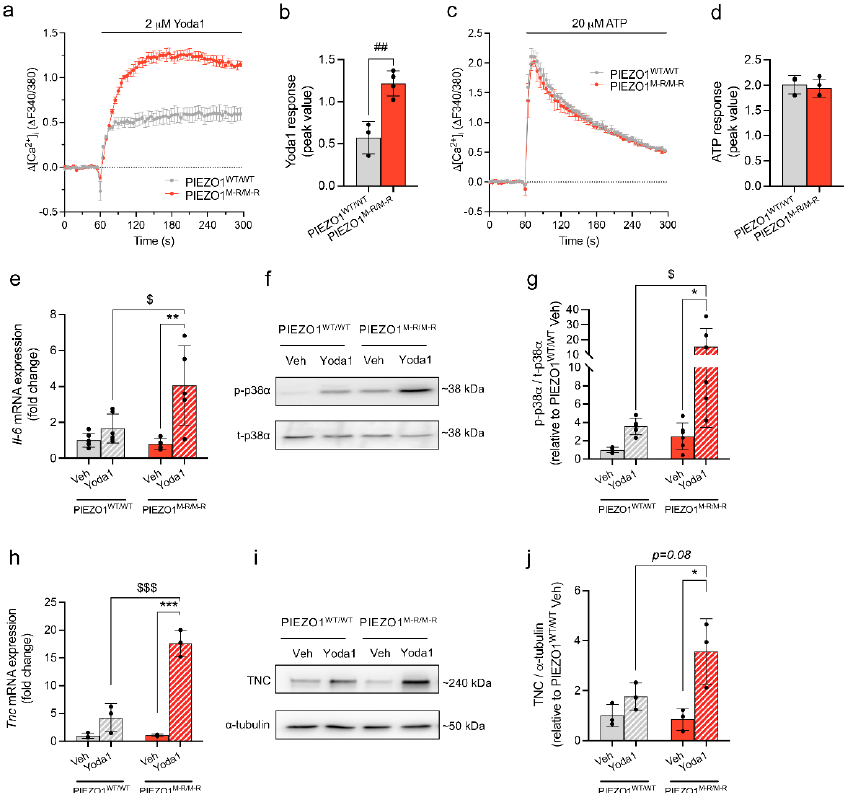
Figure 4. PIEZO1 gain-of-function mutation causes increased agonist-evoked Ca 2+ -entry in cardiac fibroblasts and amplified downstream signalling. ( a ) Examples of changes ( ∆ ) in intracellular free Ca 2+ above baseline in response to 2 µ M Yoda1 in cultured fibroblasts isolated from PIEZO1 WT/WT or PIEZO1 M-R/M-R mice ( n = 3 replicates per data point). ( b ) Mean data for the type of experiment shown in ( a ), measured 60–90 s after Yoda1 treatment. ( c ) As for ( a ), but 20 µ M ATP was used in place of Yoda1. ( d ) Mean data for the type of experiment shown in ( c ), measured 60–90 s after ATP treatment. ( e ) Quantitative PCR mRNA expression data for Il-6 gene in PIEZO1 WT/WT and PIEZO1 M-R/M-R fibroblasts exposed to 10 µ M Yoda1 or vehicle control (DMSO) for 6 h, normalised to reference gene expression, and presented as fold change relative to PIEZO1 WT/WT vehicle control. ( f ) Representative Western blot for phosphorylated p38 α protein (p-p38 α ) and total p38 α protein in PIEZO1 WT/WT and PIEZO1 M-R/M-R fibroblasts exposed to 10 µ M Yoda1 or vehicle control only (DMSO) for 10 min. ( g ) Mean data for the type of experiment shown in ( f ), quantification of p-p38 α expression relative to total p38 α expression in PIEZO1 WT/WT and PIEZO1 M-R/M-R fibroblasts. ( h ) Quantitative PCR mRNA expression data for Tnc gene in PIEZO1 WT/WT and PIEZO1 M-R/M-R fibroblasts exposed to 10 µ M Yoda1 or vehicle control (DMSO) for 6 h, normalised to reference gene expression and presented as fold-change change relative to PIEZO1 WT/WT vehicle control. ( i ) Representative Western blot for TNC protein in PIEZO1 WT/WT and PIEZO1 M-R/M-R fibroblasts exposed to 10 µ M Yoda1 or vehicle control only (DMSO) for 6 h, normalised to α -tubulin protein expression. ( j ) Mean data for the type of experiment shown in ( i ), quantification of TNC expression relative to α -tubulin expression in PIEZO1 WT/WT and PIEZO1 M-R/M-R fibroblasts. Data are for n = 3 PIEZO1 WT/WT and 4 PIEZO1 M-R/M-R mice for ( a – d ); n = 6 PIEZO1 WT/WT and 5 PIEZO1 M-R/M-R mice for ( e ); n = 5 PIEZO1 WT/WT and 6 PIEZO1 M-R/M-R mice for ( f , g ); n = 3 PIEZO1 WT/WT and 3 PIEZO1 M-R/M-R mice for ( h – j ) (mean ± S.D.). Superimposed dots represent the individual values for each animal. ## p < 0.01 vs. PIEZO1 WT/WT mice. * p < 0.05; ** p < 0.01; *** p < 0.001 vs. PIEZO1 M-R/M-R vehicle-treated fibroblasts. $ p < 0.05; $$$ p < 0.001 vs. PIEZO1 WT/WT Yoda1-treated fibroblasts. Statistical significance was evaluated using unpaired Student’s t -test in ( b , d ); and using two-way ANOVA followed by Tukey’s HSD post hoc test for multiple comparisons in ( e , g , h , j